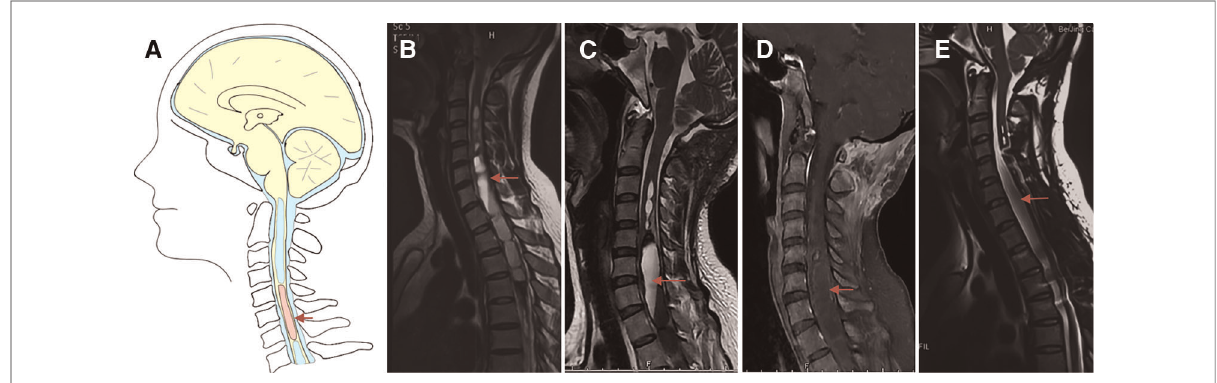
FIGURE 5 Case presentation of spinal cord tumor in Group III, a 28-year-old woman with progressive weakness and numbness of both lower limbs who received failed suboccipital decompression in local hospital 1.5 months ago. ( A ) Schematic drawings of the cervical spine, sagittal view. ( B ) Preoperative sagittal T2-weighted MRI showed large syringomyelia. ( C,D ) Postoperative enhanced MRI showed partial bone defects of posterior inferior border of occipital bone, spinal cord thickening with abnormal signal at the level of C5-T6, central canal dilation at C3-5 and T7-9, previous intramedullary hemorrhage at T10-11 level. ( E ) Postoperative MRI after 6 months showed obvious reduction of syringomyelia. Under electrophysiological monitoring, the tumor was completely removed, and the postoperative pathological results were astrocytoma, WHO grade I. Arrow: spinal cord tumor.